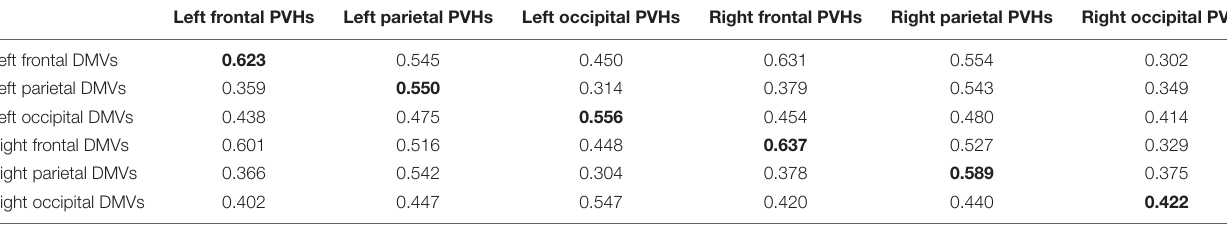
TABLE 3 | The correlation of DMVs and PVHs in different brain regions.